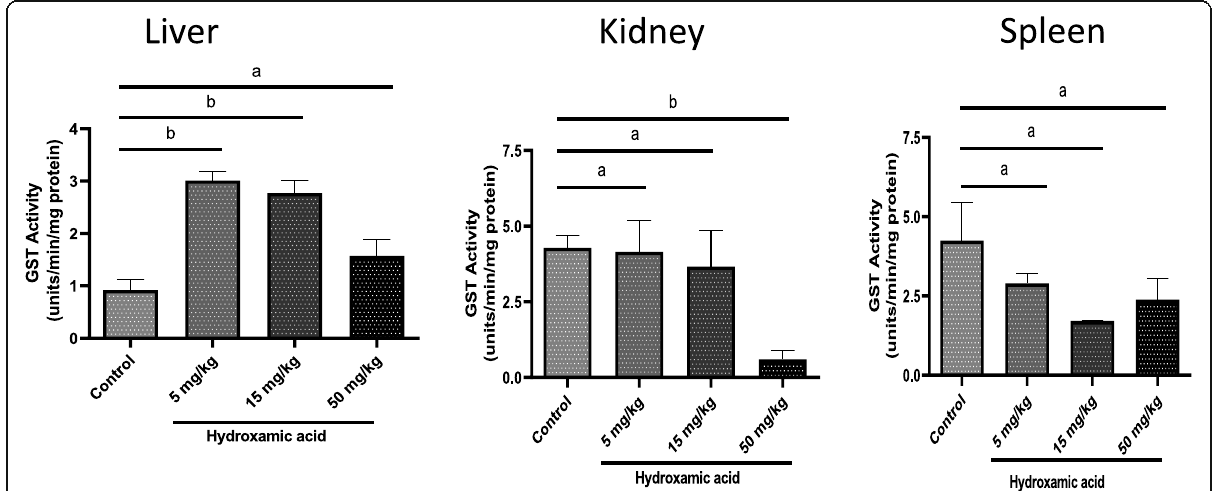
Fig. 4 Glutathione S-transferase activity in liver, kidney, and spleen. Values are expressed as mean ± SEM; ( n = 5). Different letters indicate significant difference at p <